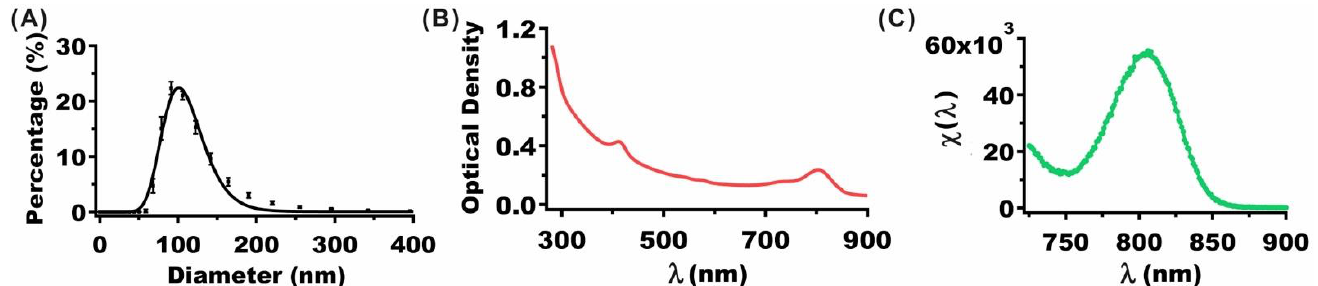
Figure 2. ( A ) Hydrodynamic diameter distribution of nRBCs-ICG as determined by DLS. Squares and error bars represent the measured mean and standard deviation (SD) of diameters, respectively ( n = 8 measurements of the same sample). The estimated mean peak diameter as determined from a log-normal fit (solid curves) was ~101 nm. ( B ) OD spectrum of nRBCs-ICG. ( C ) Normalized fluorescence spectrum (see Equation (1)) of nRBCs-ICG in response to photo-excitation at 710 nm. The suspension of nRBCs-ICG in 1× PBS was diluted by factor of 200 for both OD and Fluorescence measurements. ICG concentration used in the loading buffer to fabricate these nRBCs-ICG was 25 µM.